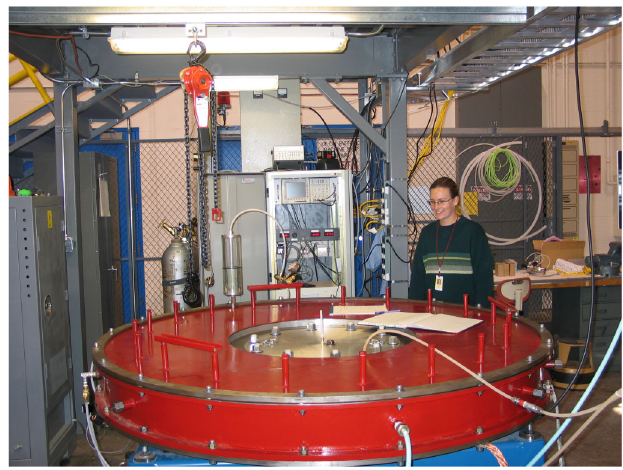
FIG. 9. (Color) The High Current LTD